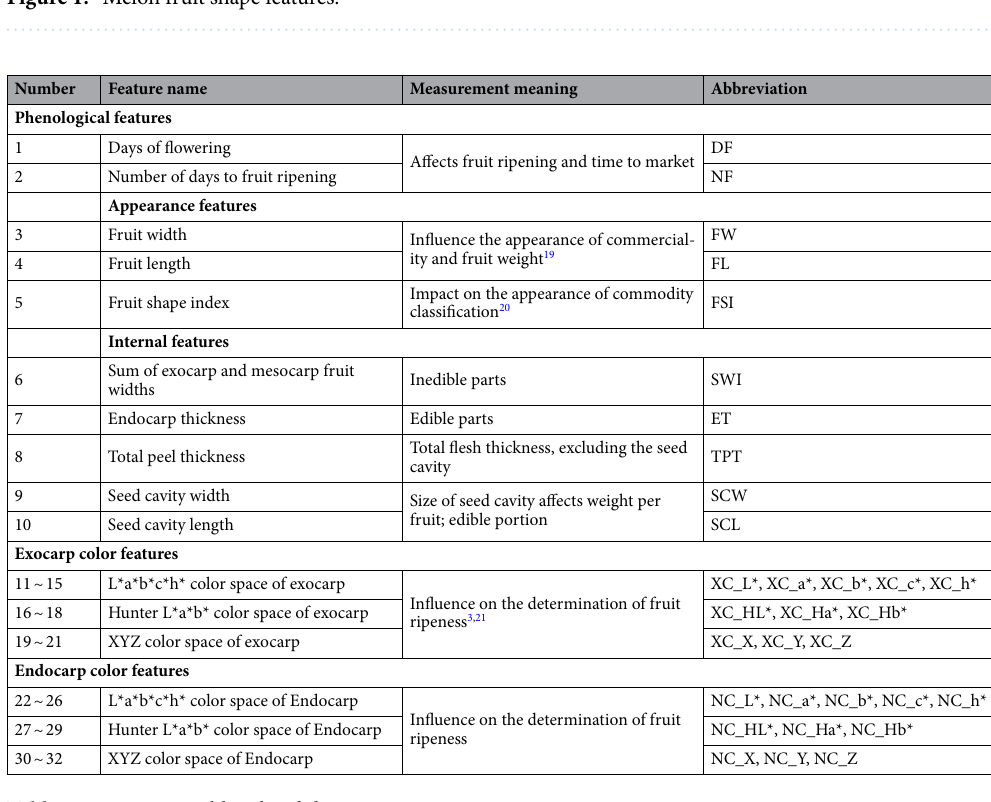
Figure 1. Melon fruit shape features.